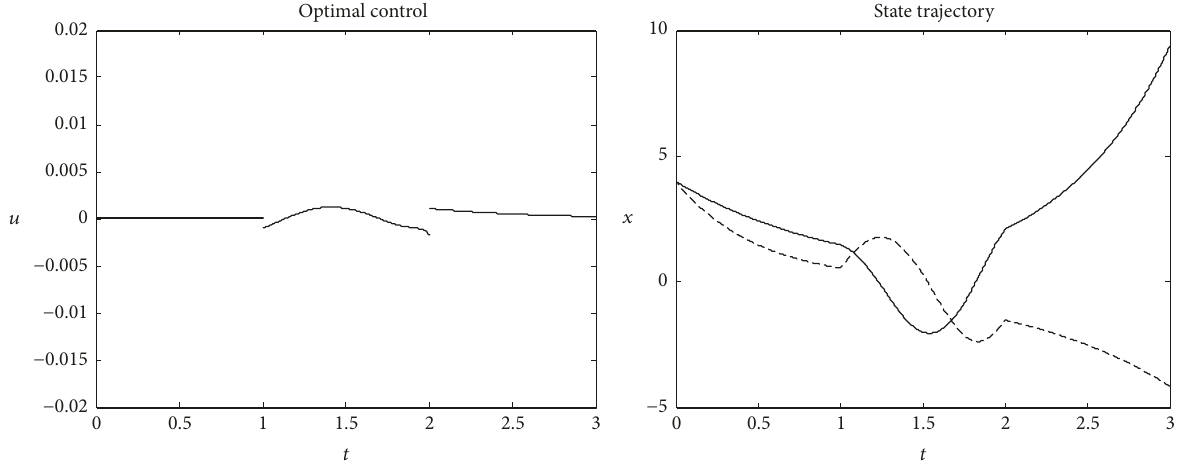
Figure 4: Control input and optimal state